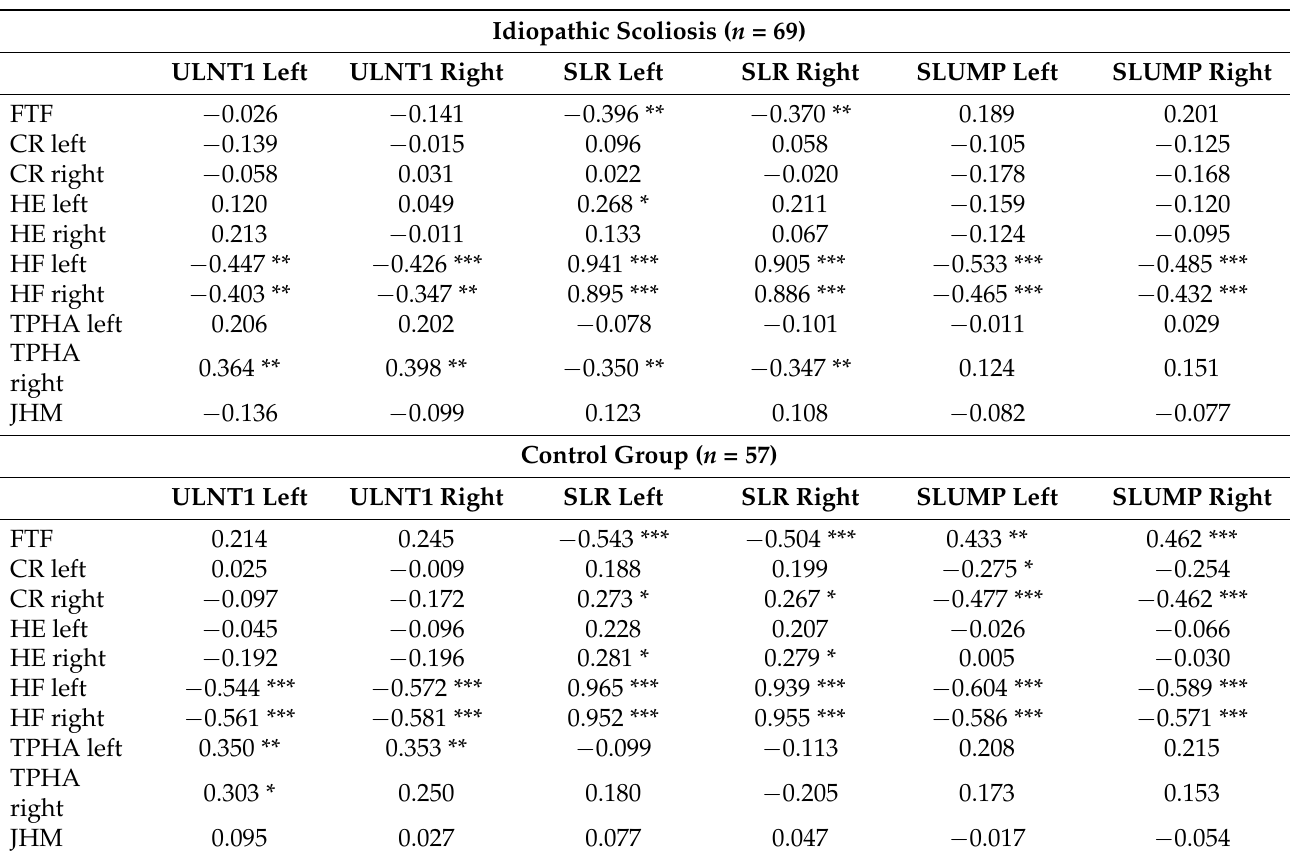
Table 5. Correlations between neurodynamic tests and ranges of motion in adolescents with idio- pathic scoliosis (IS) and the control group